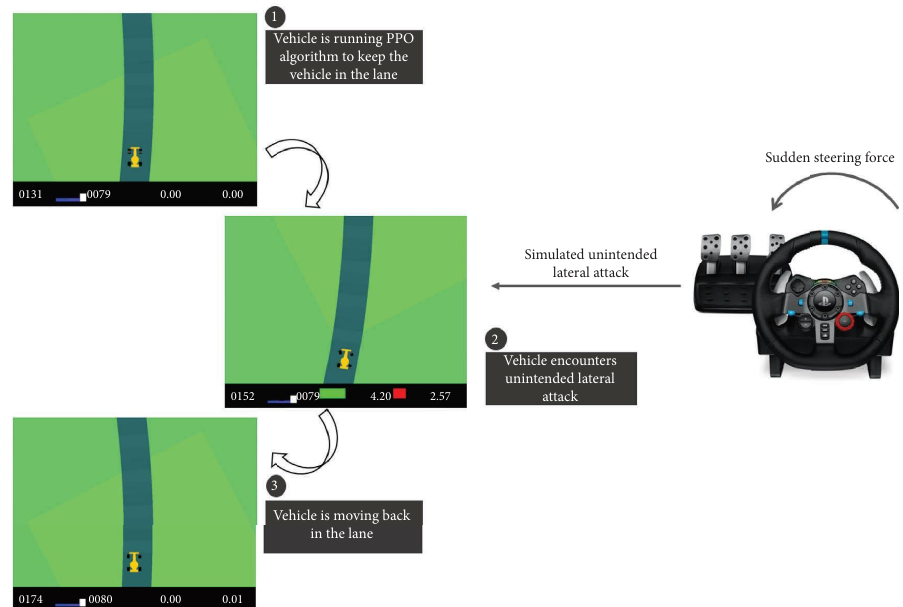
Figure 8: Simulated unintended lateral attack. Use external driving force to simulate the unintended lateral